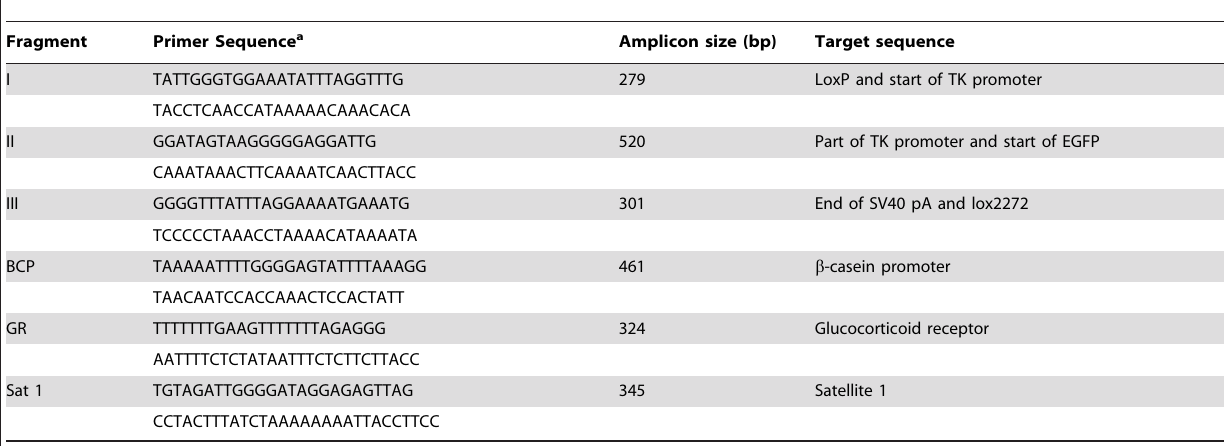
Table 2. PCR primer pairs used for DNA methylation